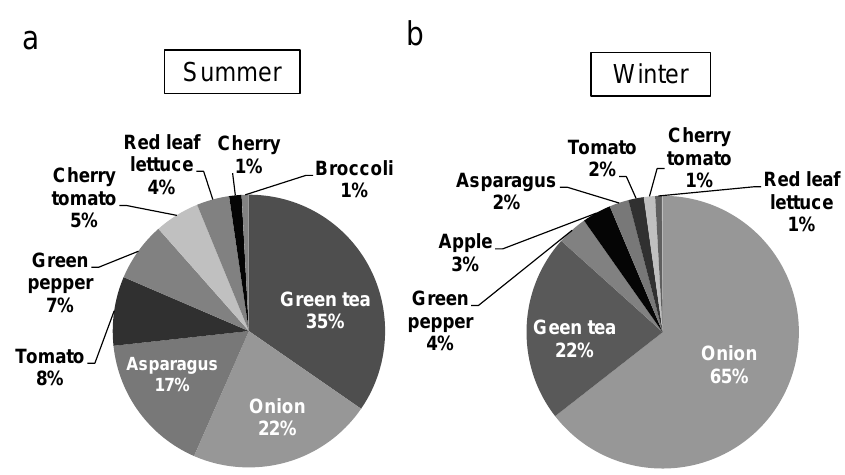
Figure 3. Percentage contribution of foods to the daily quercetin intake by residents of Sobetsu in Hokkaido during summer ( a ) and winter ( b